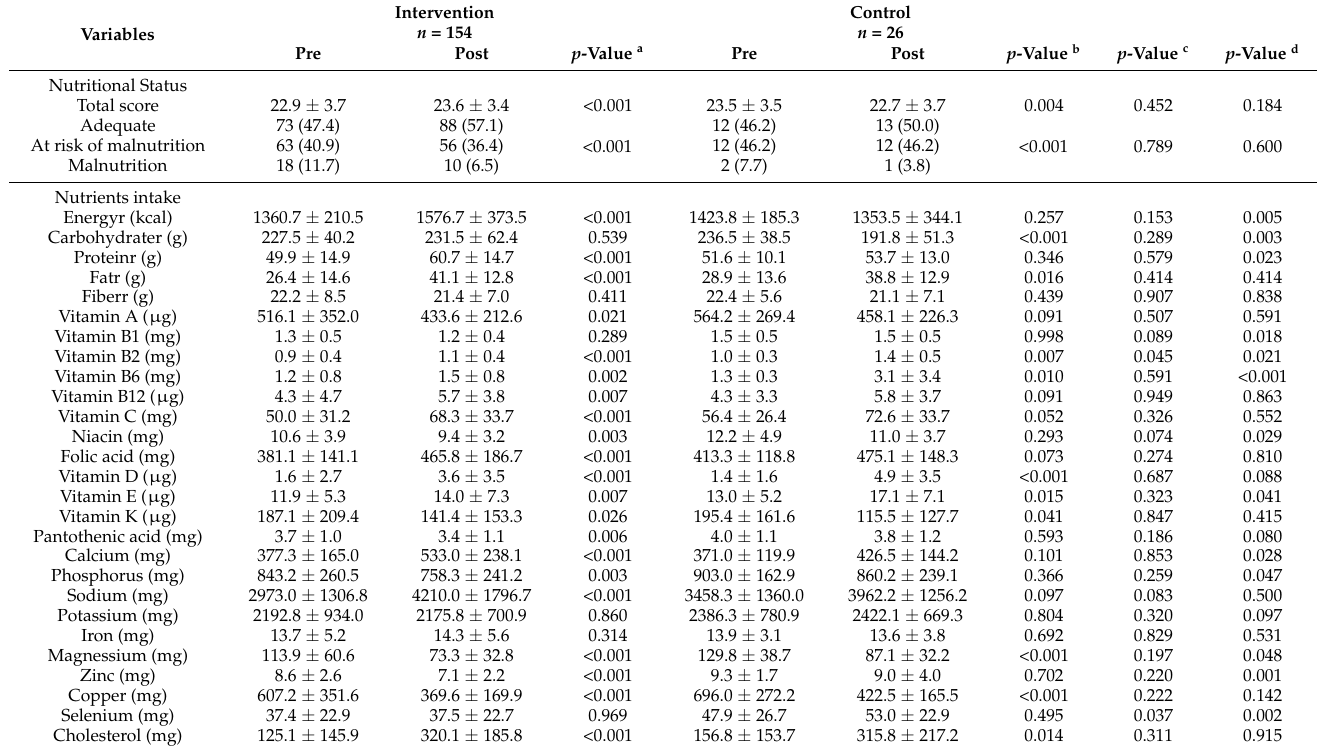
Table 2. Changes of nutritional status for each